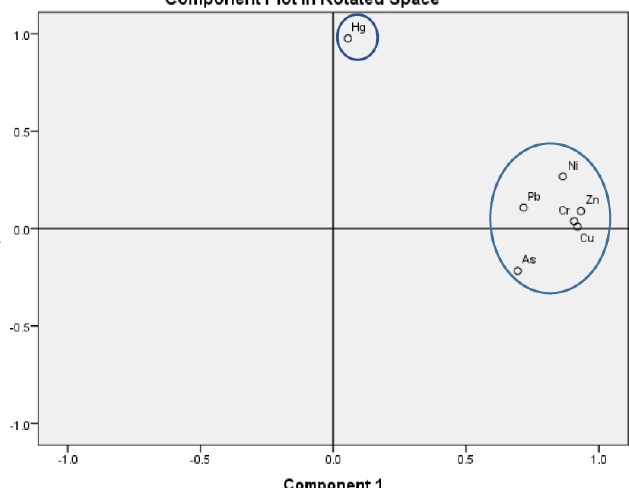
Figure 6. Factor analysis and distribution of PTEs in two component plots.